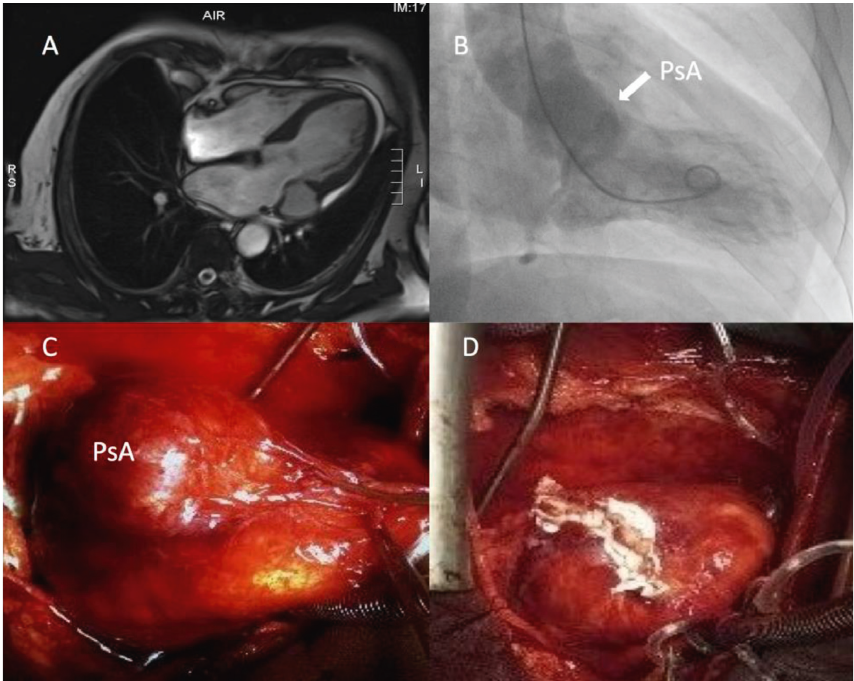
Figure 2: Cardiac magnetic resonance showing the pseudoaneurysm (A); the pseudoaneurysm (PsA) seen at contrast ventriculography (B, arrow); surgical view of the PsA before (C) and after resection